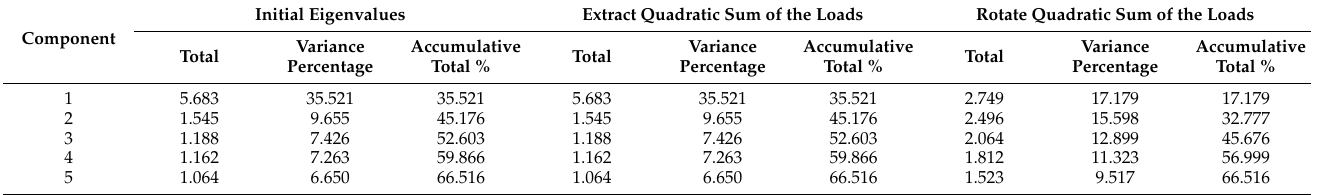
Table A2. Total variance explained (number of variables = 16, number of valid questionnaires =